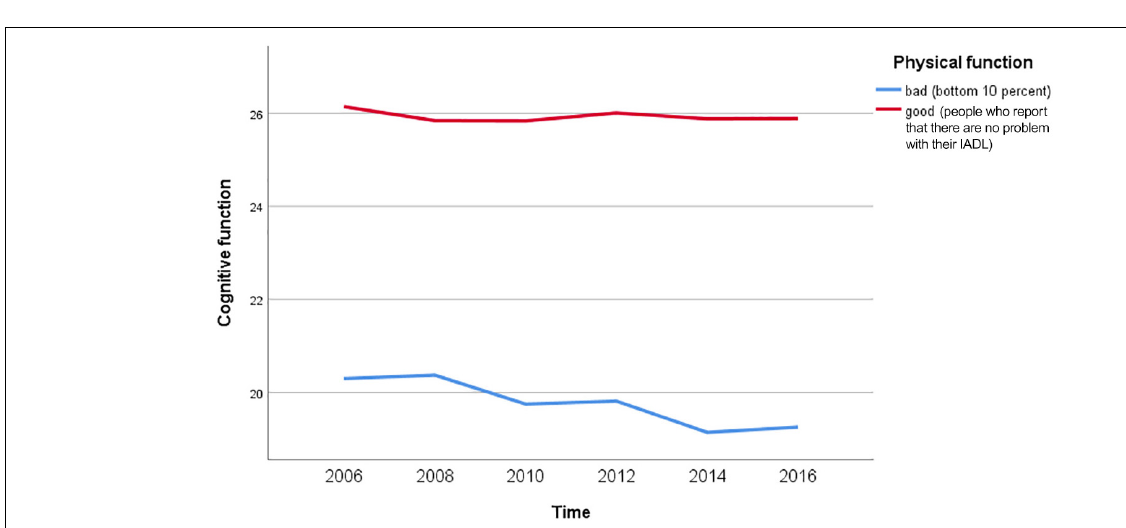
FIGURE 3 | Cognitive function according to the level of physical function